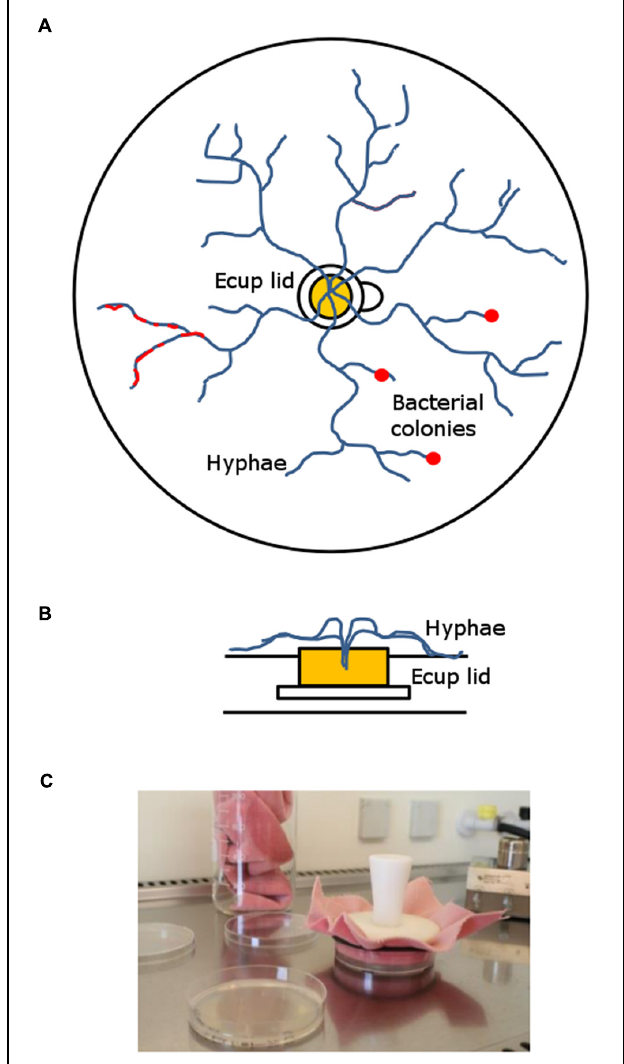
FIGURE 1 | Long-term hyphal-baiting (“transfer-enrichment”) approach. (A) Top-view and (B) side-view. The fungus was inoculated in the lid of an Eppendorf Cup containing Malt extract agar. It overgrew the plastic rim which separated the nutrient containing compartment (Malt extract agar) in the lid from the nutrient-poor Phytagel in the Petri dish. Subsequently, the microcosm was colonized by the fungal hyphae. Bacteria were distributed over the Phytagel compartment after colonization by the hyphae and strains that became enriched appeared as a biofilm or small colonies along fungal hyphae (red). (C) Regular transfers were done to promote the enrichment of those bacteria that can exploit fungal hyphae for carbon.